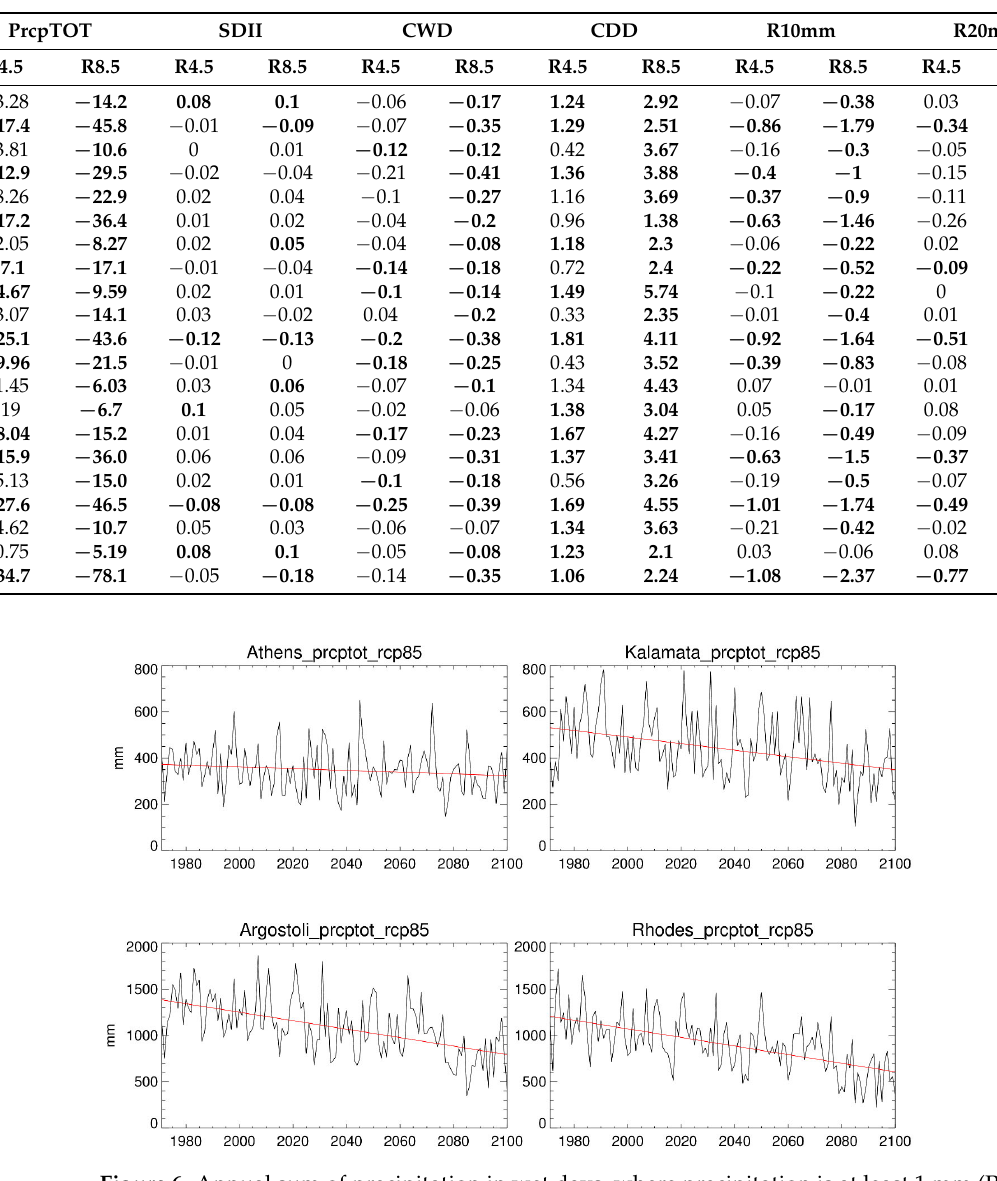
Table 3. Decadal trends in annual extreme precipitation indices under RCP4.5 and RCP8.5 for 21 Greek stations during the period 1971–2100 (numbers in bold indicate statistically significant slopes, p < 0.05).